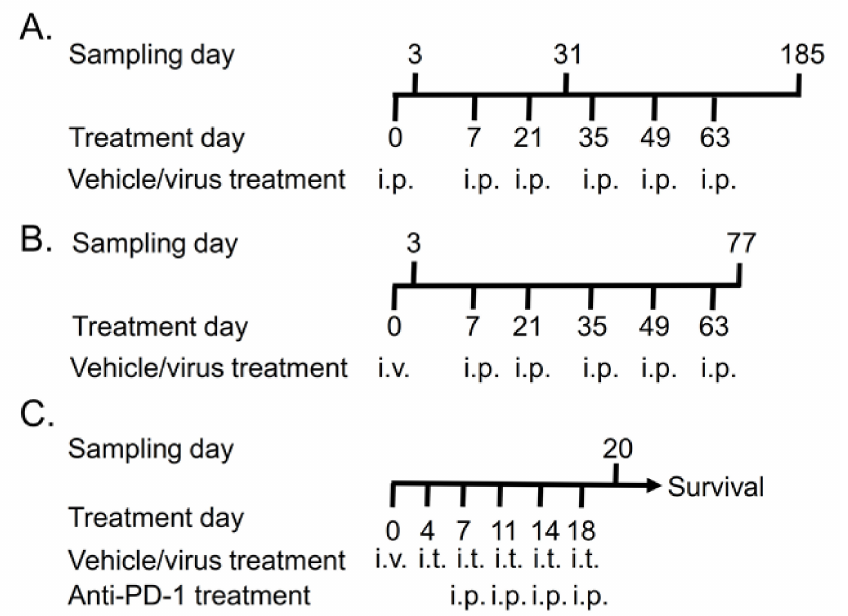
Figure 1. Treatment schedule for TILT-123 safety studies: ( A ) 15 male and female hamsters received saline or 1 × 10 10 , 1 × 10 11 , or 1 × 10 12 virus particles (VP)/kg of TILT-123 six times intraperitoneally (i.p.). Five animals/sex/group were sacrificed 3, 31, and 185 days after the first treatment. ( B ) Ten male and female hamsters received saline, 1 × 10 11 VP/kg, or 1 × 10 12 VP/kg of TILT-123 once intravenously (i.v.) and five times i.p. Five animals/sex/group were sacrificed 3 days after the first injection and two weeks after the last injections (on day 77). ( C ) Human fibrosarcoma tumors were implanted subcutaneously to both flanks of nude NMRI mice. Nine days after implantation, the animals received 1 × 10 5 VP, 1 × 10 7 VP, or 1 × 10 9 VP i.v. The following treatments were injected intratumorally (i.t.) Anti-PD-1 (100 µ g) treatments were started on day 7 after two virus treatments. Five animals per group were sacrificed on day 20, and the rest (6–7 animals/group) continued in the survival